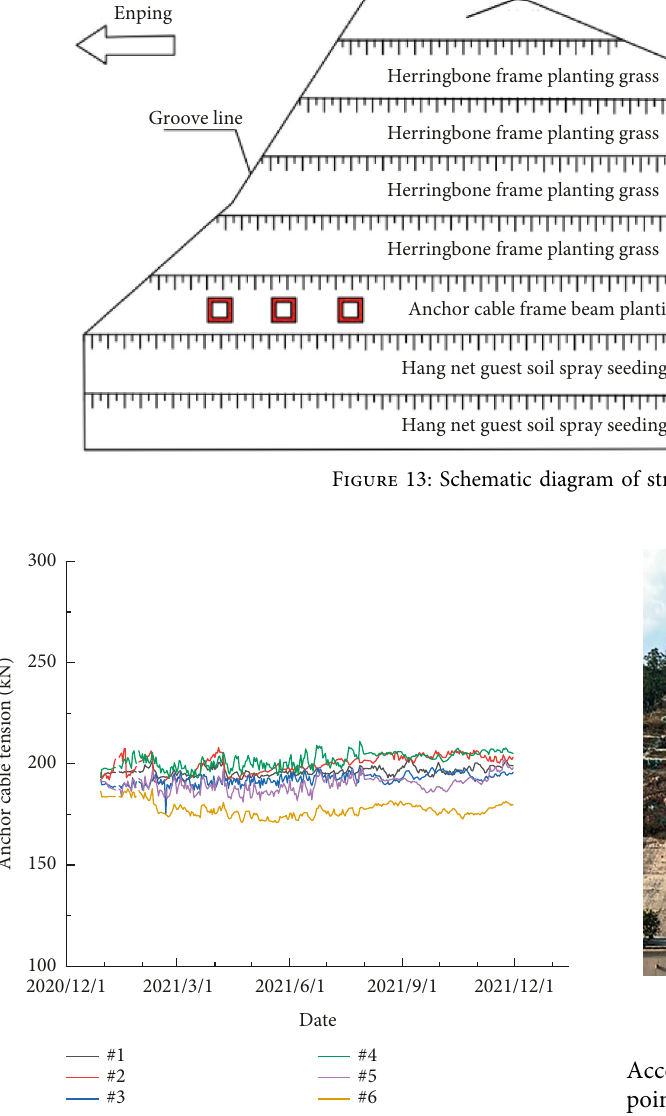
Figure 14: Stress monitoring results.